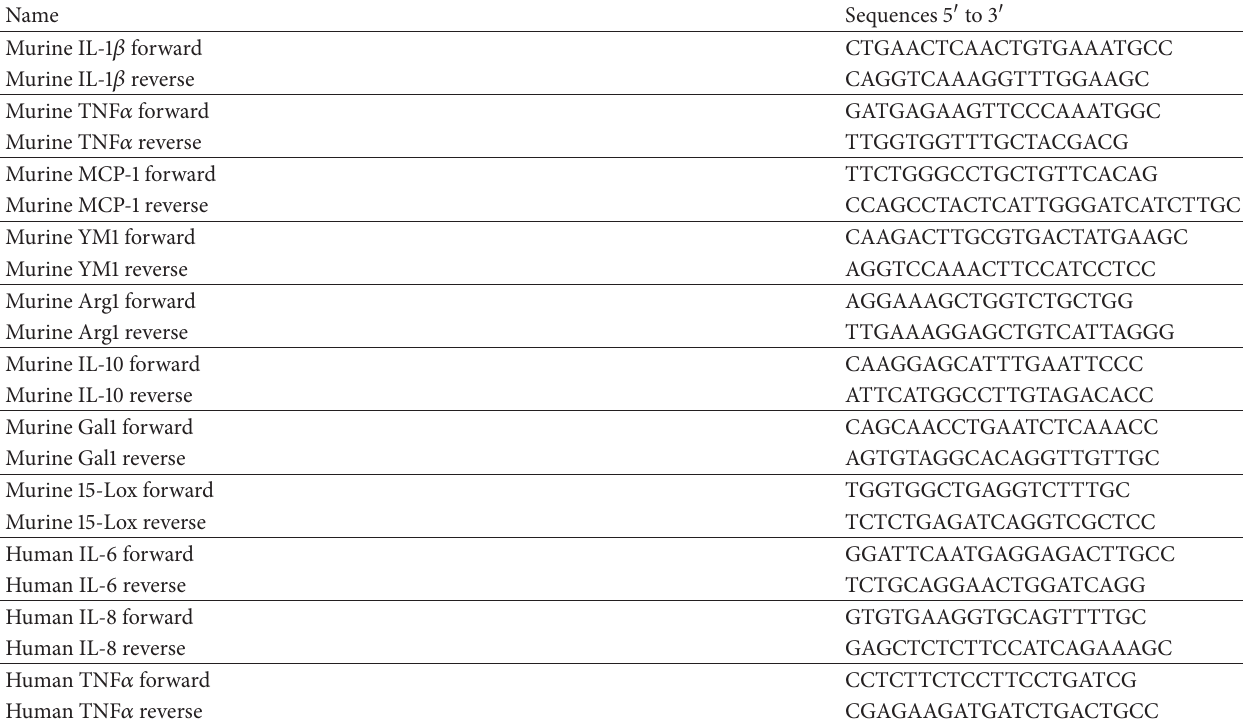
Table 1: Primer sequences for real time quantitative